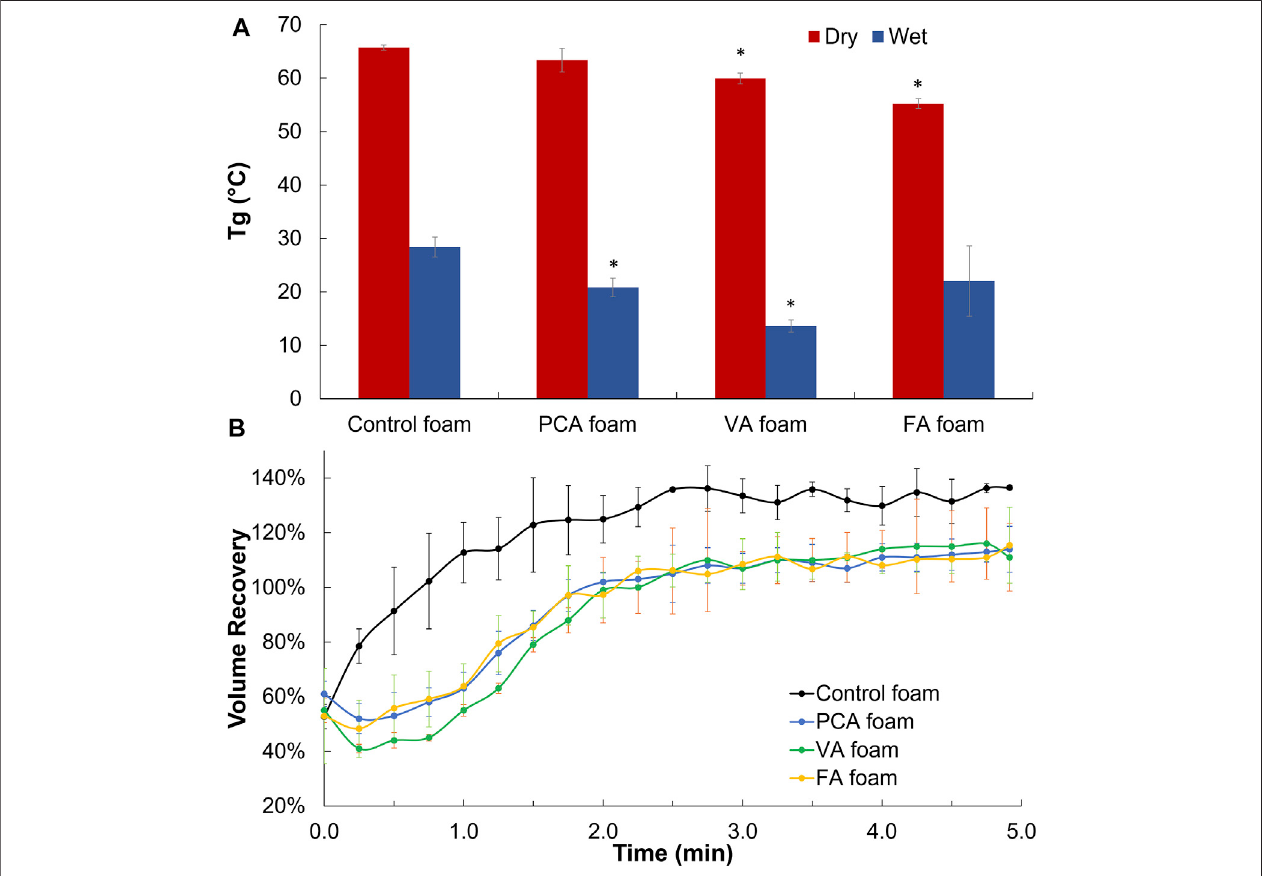
FIGURE 4 | Thermal and shape memory properties of PA-containing SMP foams. (A) Dry and wet glass temperature ( T g). (B) Volume recovery pro fi le in body temperature water. n = 3, mean ± standard deviation displayed, * p < 0.05 relative to control foam in same condition.